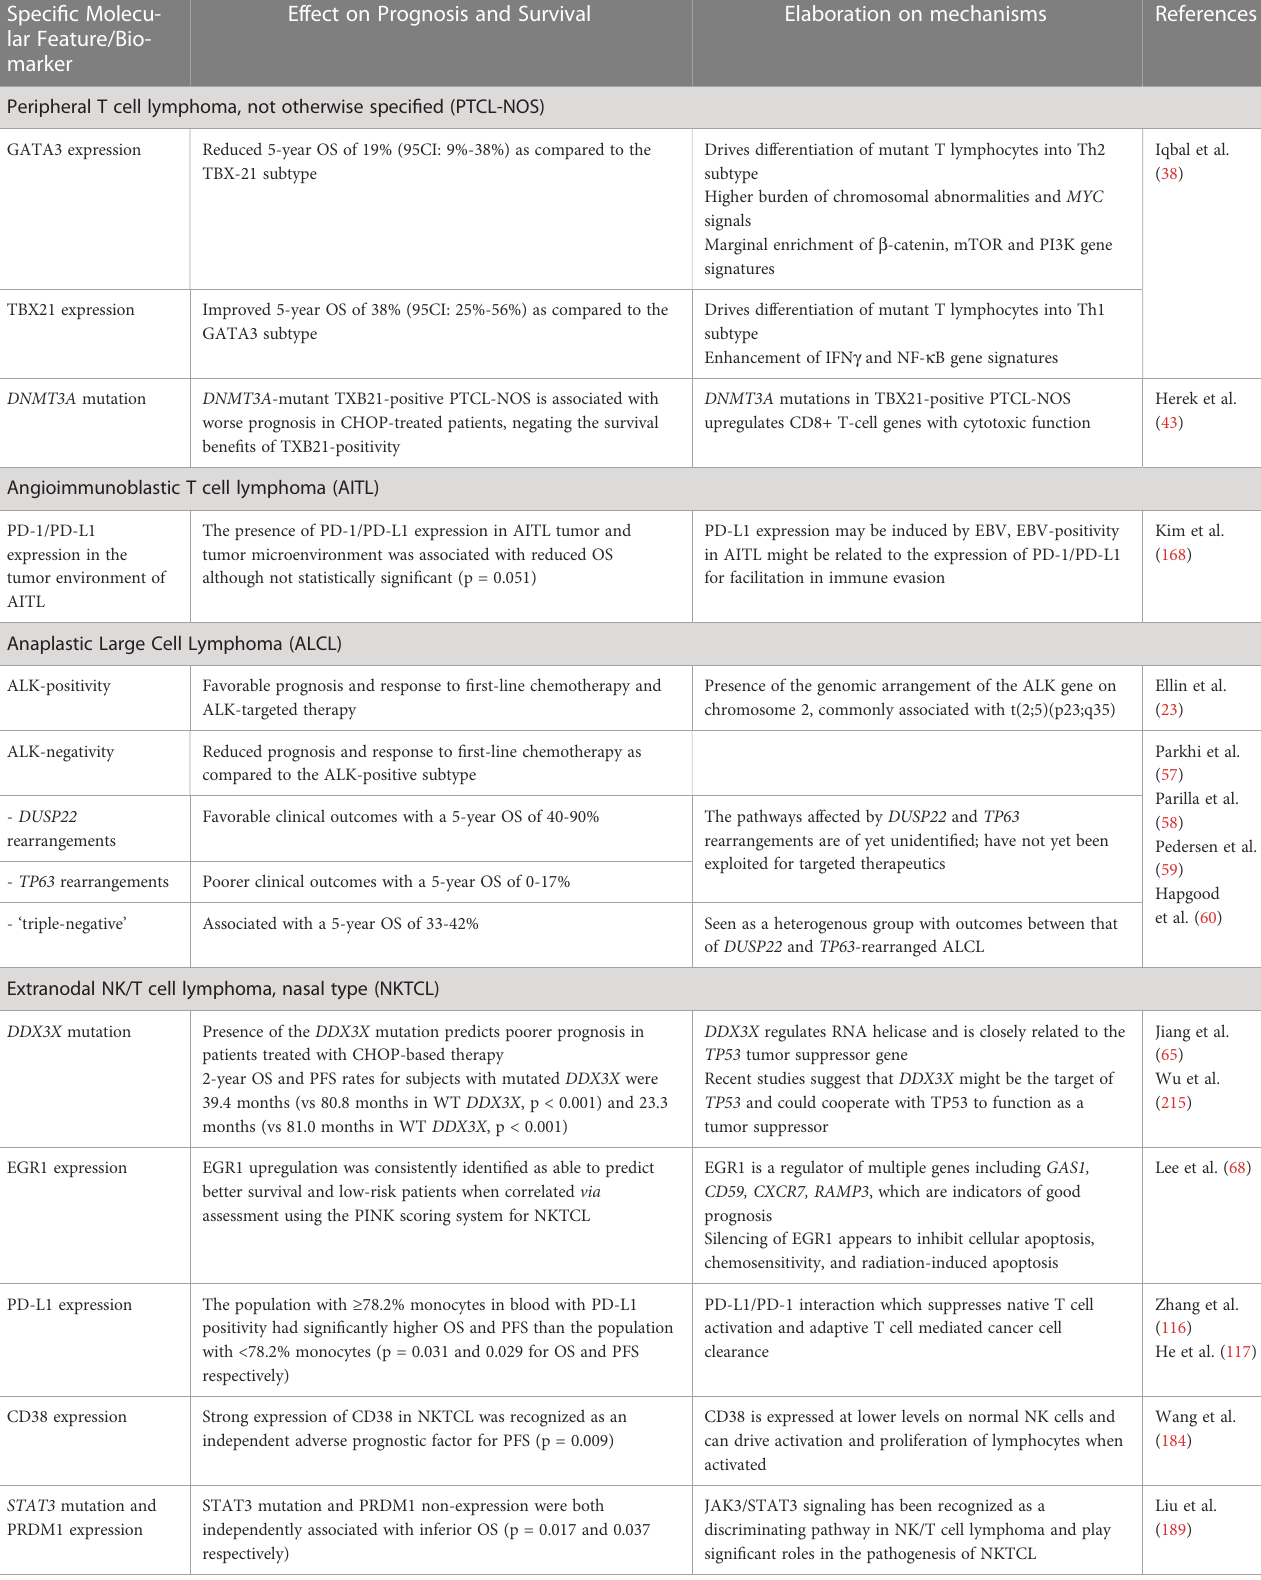
TABLE 3 Summary of the effect of speci fi c molecular features and biomarkers on prognosis and survival. Speci fi c